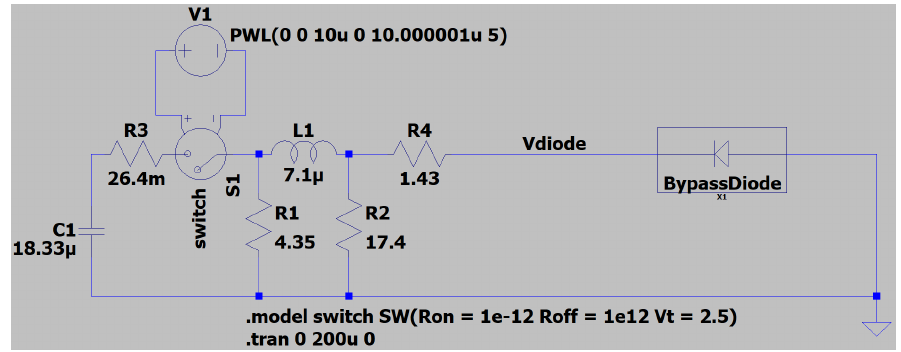
Figure 31. LTspice large-signal stimulus test circuit, shown with the full circuital diode model in the reverse